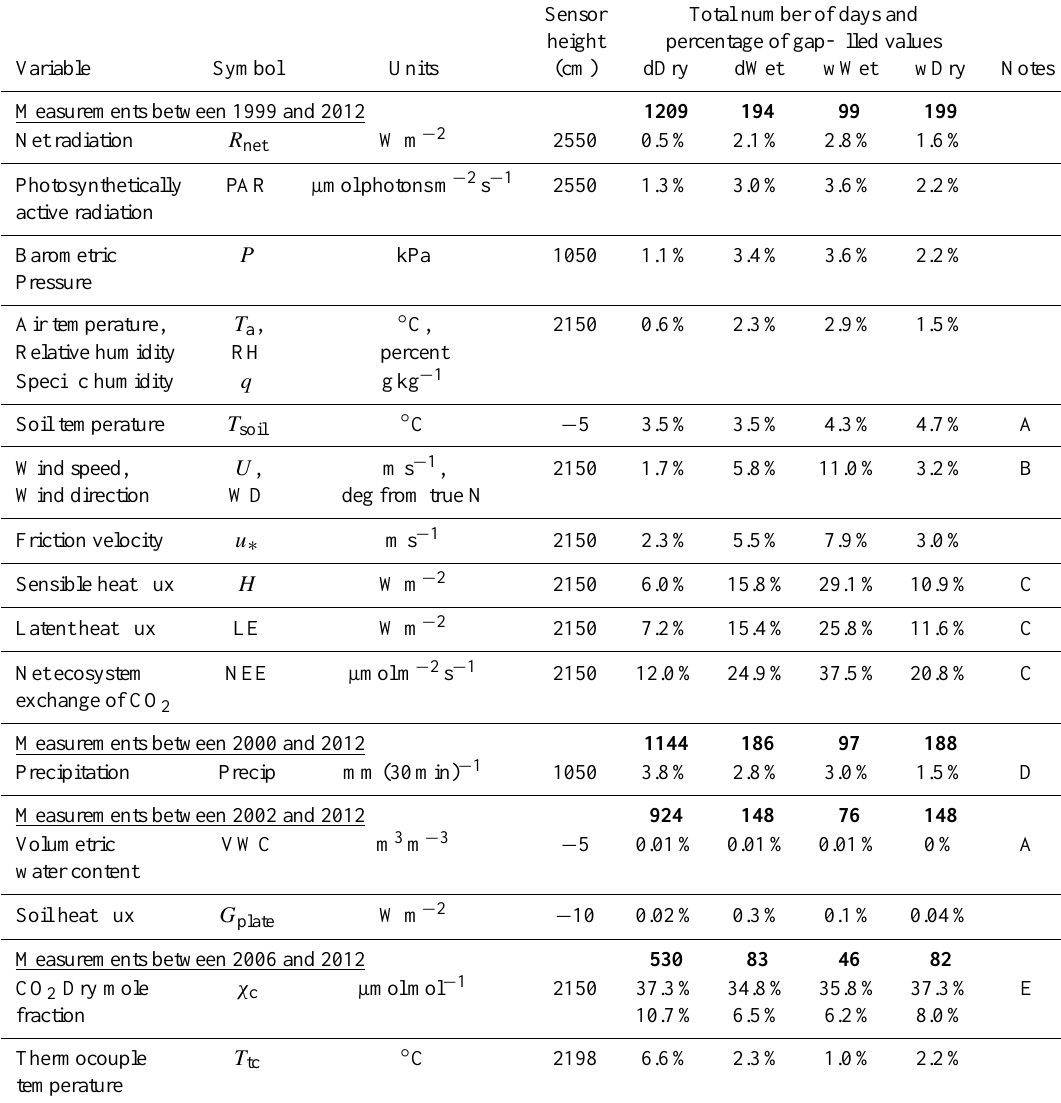
Table 2. Variables, symbols, units, and height above ground of measurements along with the number of days each variable falls within each precipitation category. Where appropriate, the percentage gap-filled 30min data for each particular variable is shown. If any variable is missing for a 30min period, then all variables within that particular group are